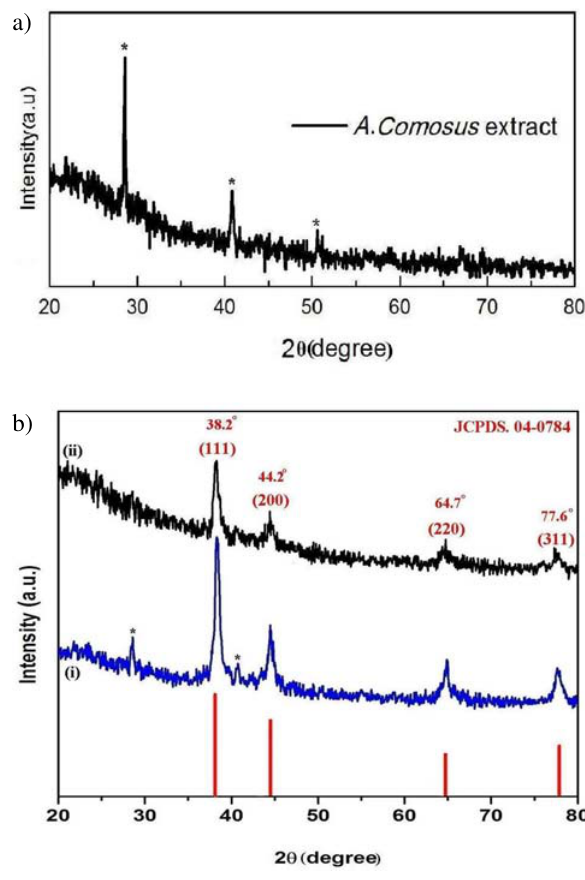
Figure 2. X-ray diffraction pattern of (a) A.comosus fruit extract and (b) AuNPs (i) g1 and (ii)